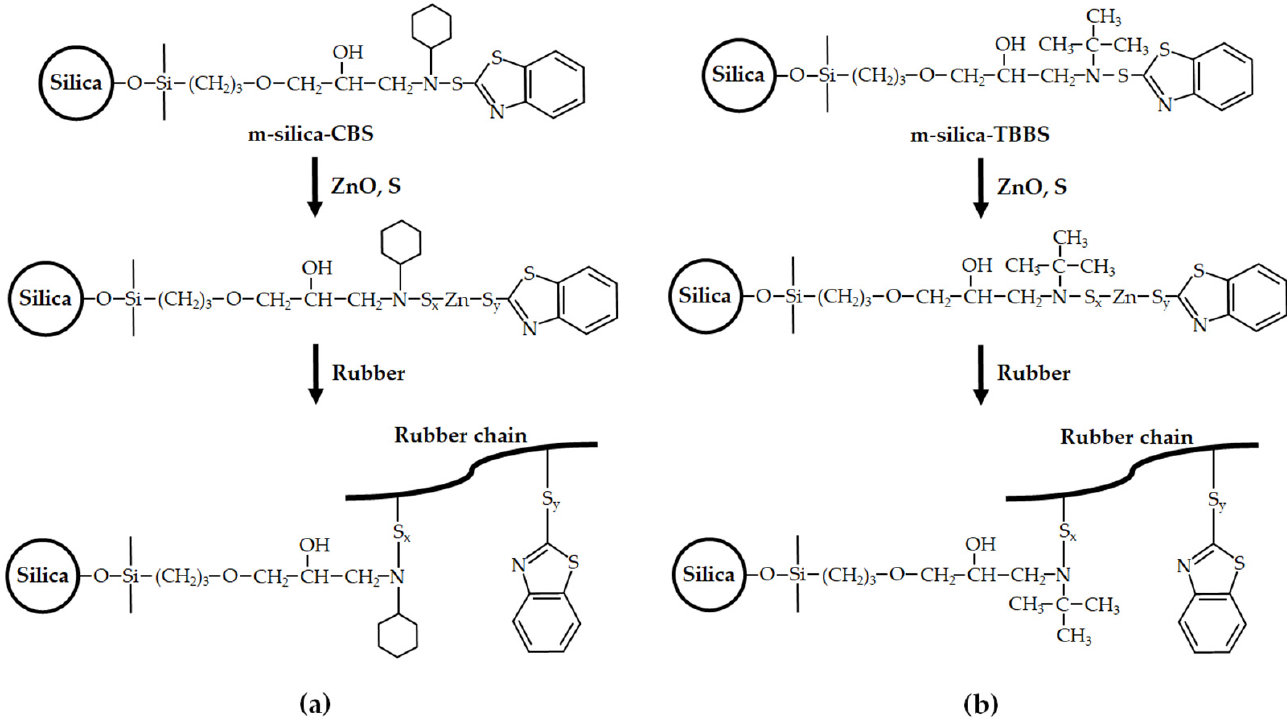
Figure 5. Chemical reactions of the modified silica surface in rubber ( a ) m-silica-CBS and ( b ) m-silica-TBBS).